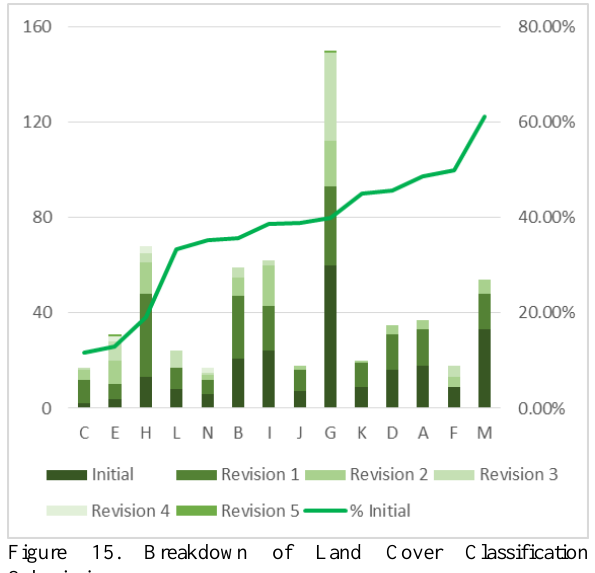
Figure 15. Breakdown of Land Cover Classification Submissions